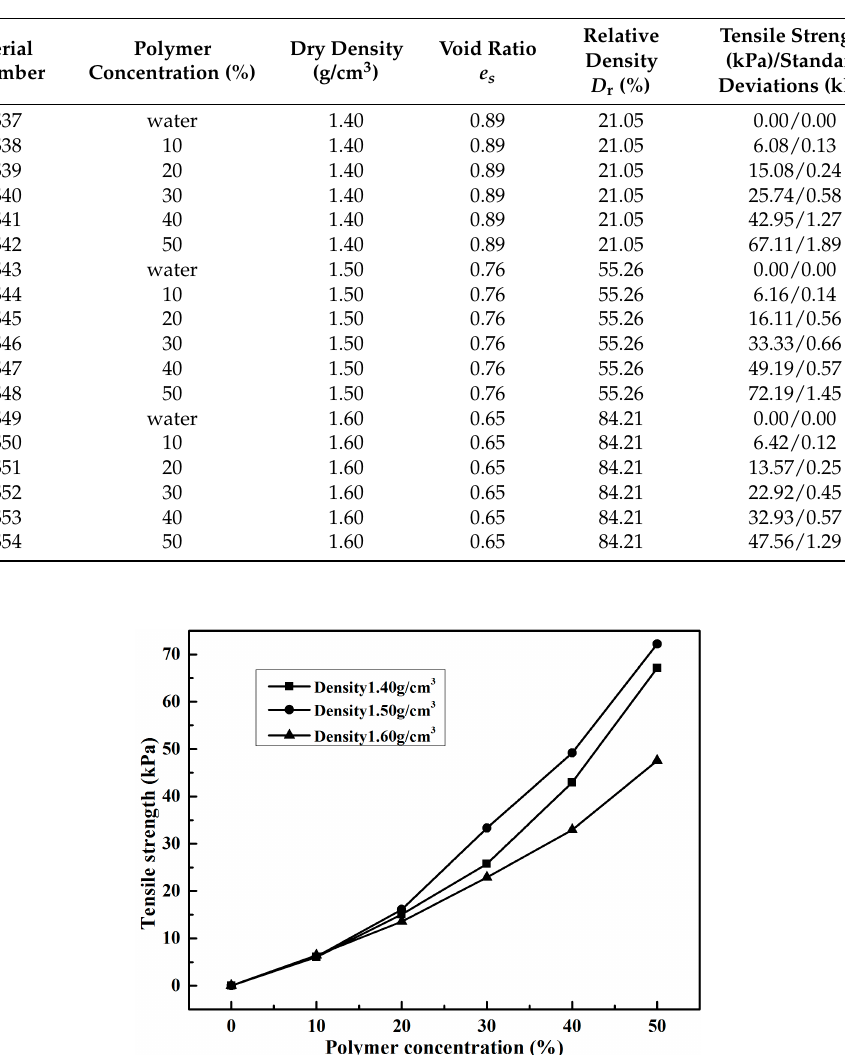
Table 3. Results of tensile tests.